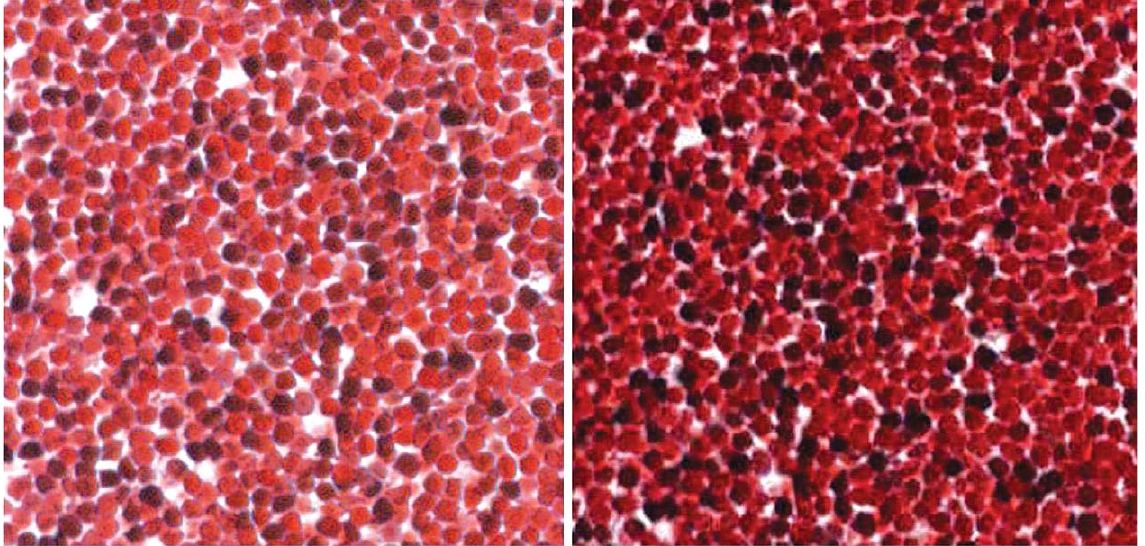
Fig. 5. (The difference in colors at QF 90 is retained at QF